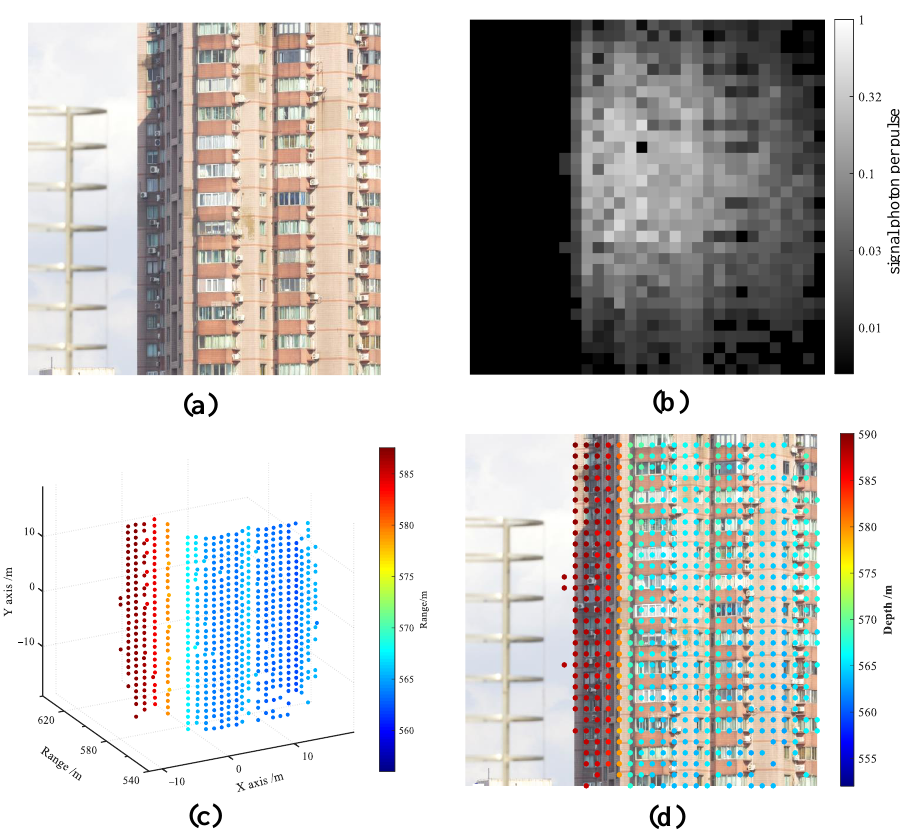
Figure 7. Experimental results obtained from the 3D imaging results of a building located approxi- mately 500 m away from the detector. ( a ) image obtained from visible-light camera; ( b ) gray image recovered from photon data, which represent the distribution of signal photon number per pulse; ( c ) 3D point cloud reconstructed by data processing unit; ( d ) fusion of depth profile and visible